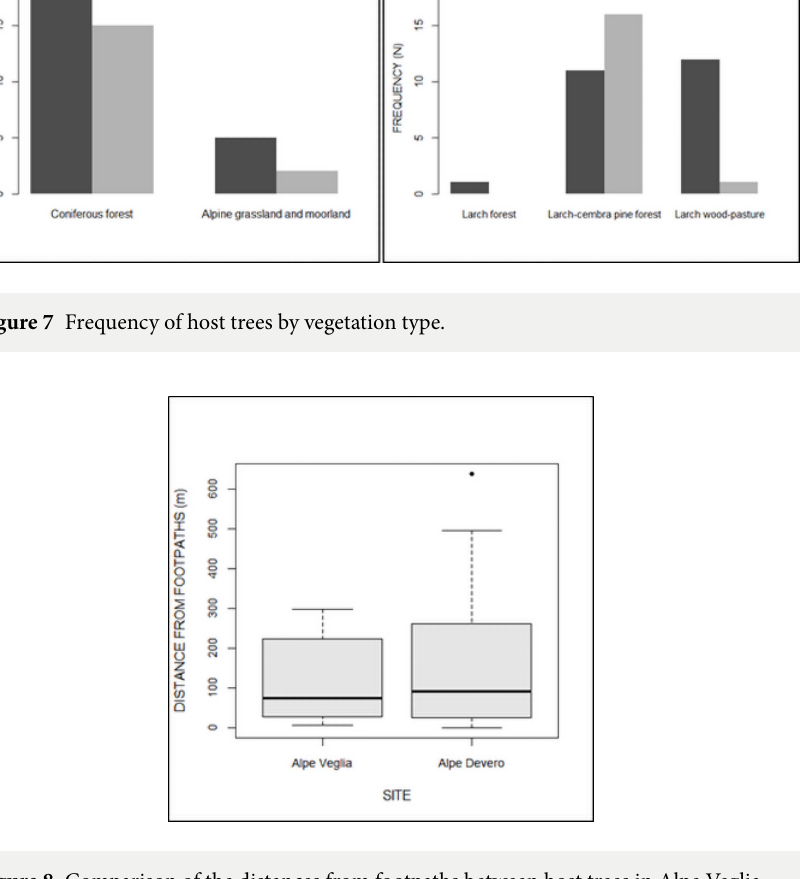
Figure 8 Comparison of the distances from footpaths between host trees in Alpe Veglia and Alpe